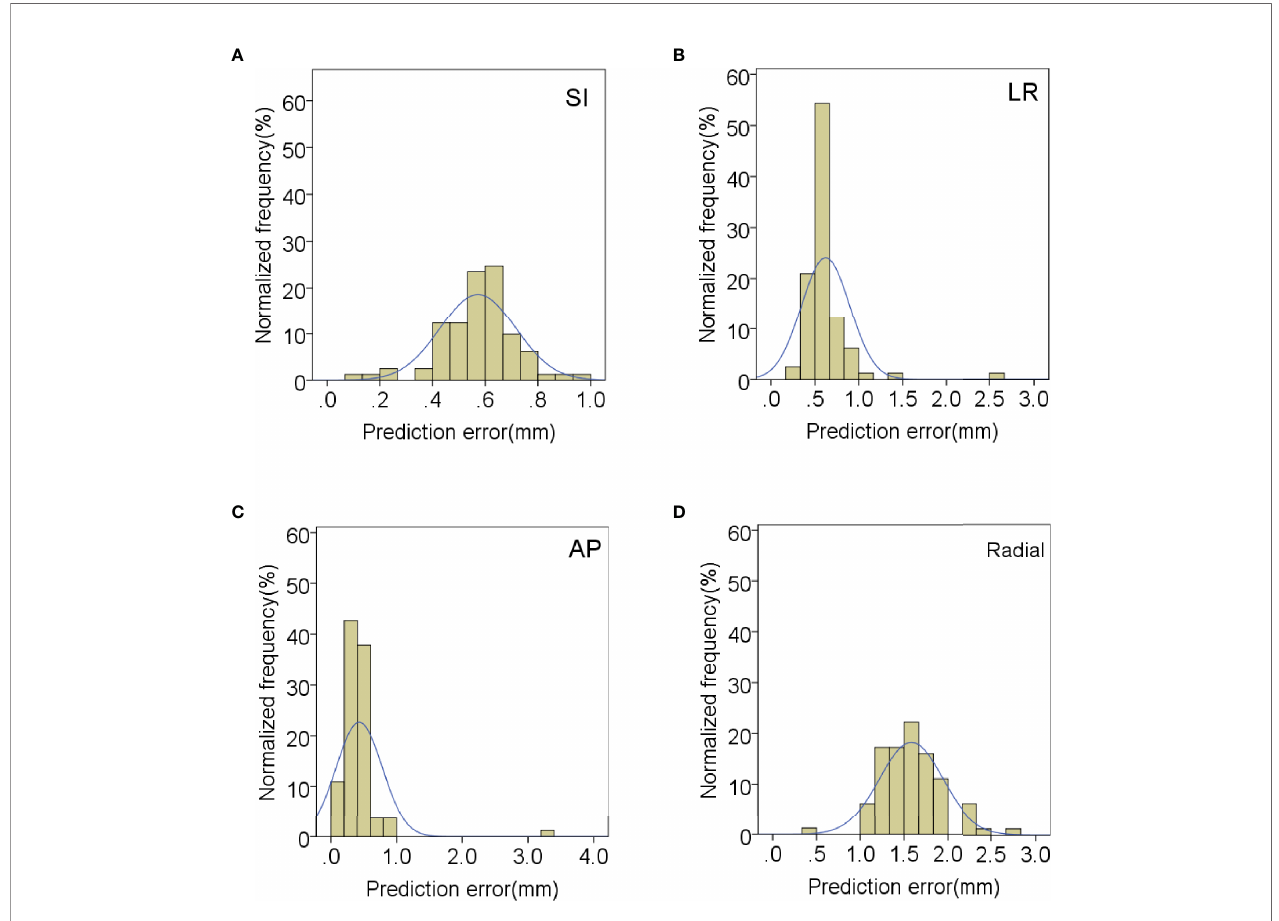
FIGURE 2 | Distribution of mean prediction errors in (A) SI, (B) LR, (C) AP and (D) radial directions.